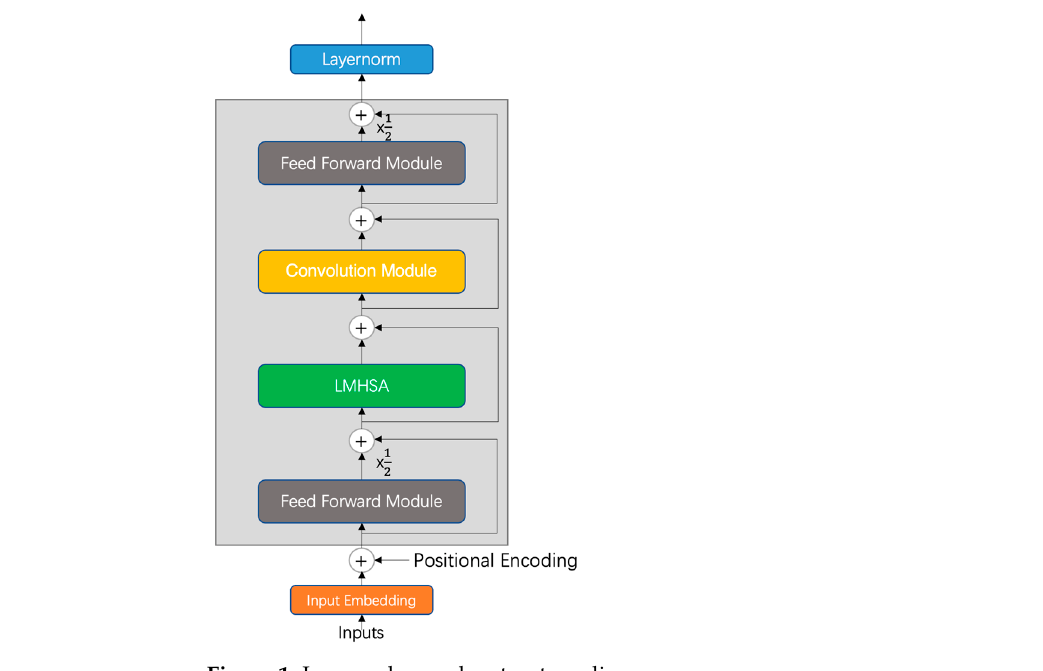
Figure 1. Low-rank encoder structure diagram.